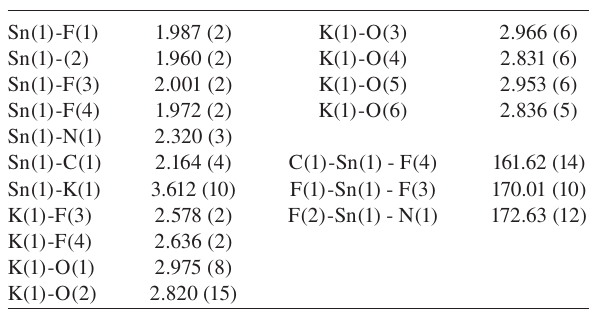
Table 1 Selected interatomic distances ( Å ) and angles (degrees) in